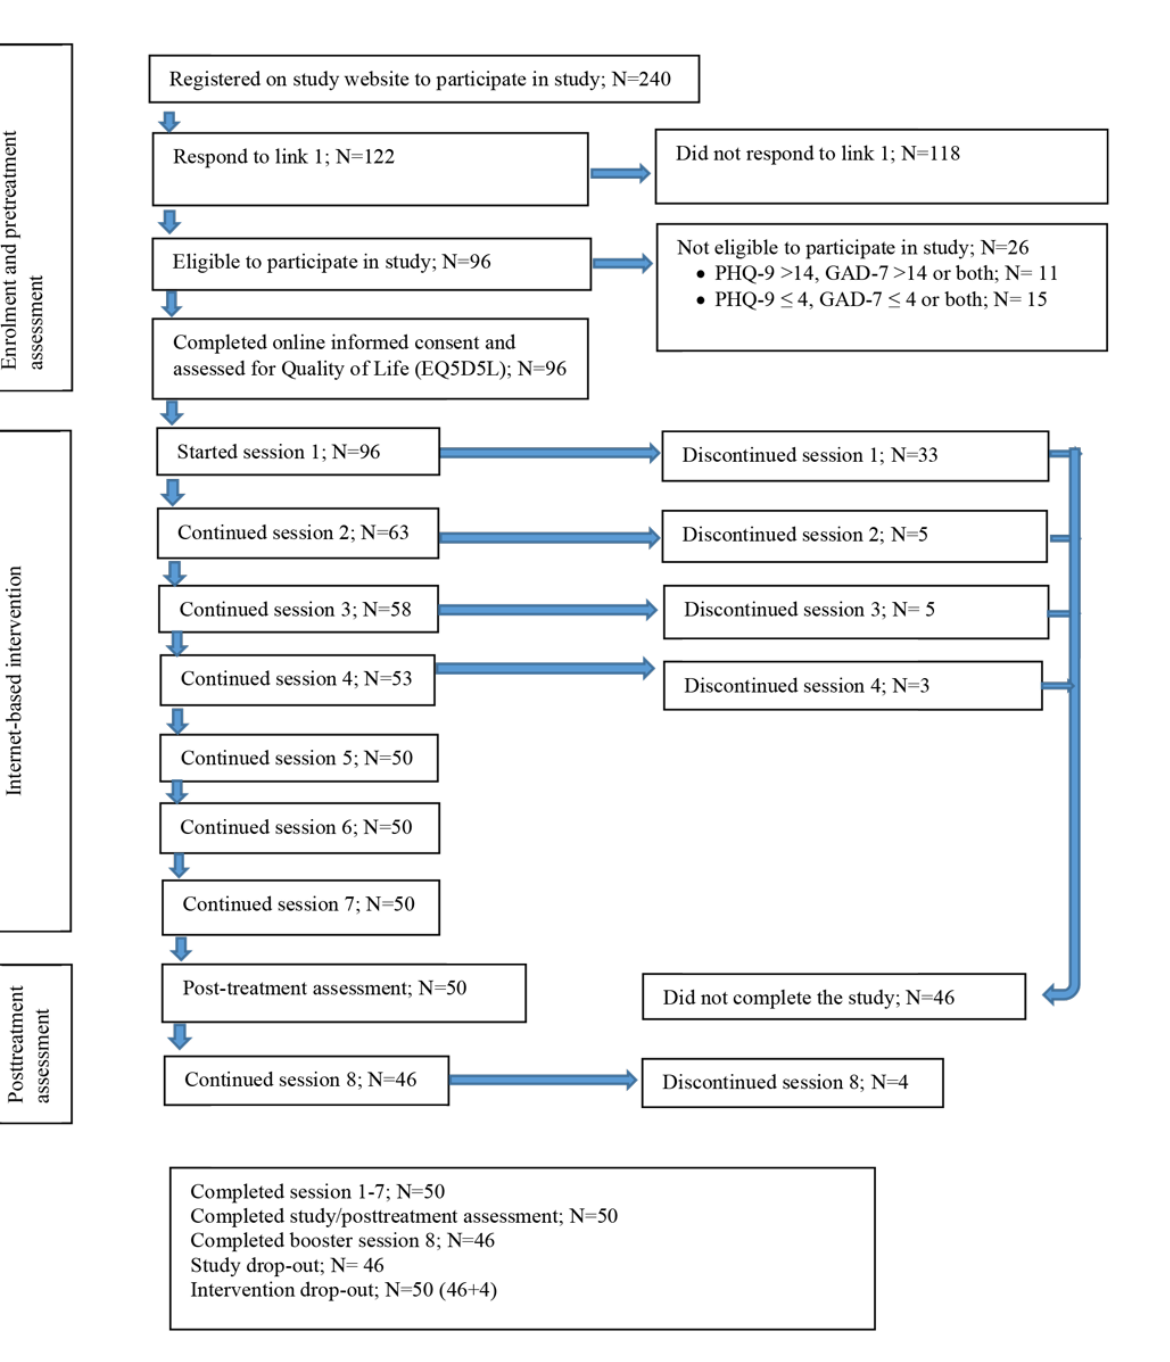
The demographic characteristics of the participants and baseline differences between completers and dropouts are presented in Table 3. There were no significant differences in baseline